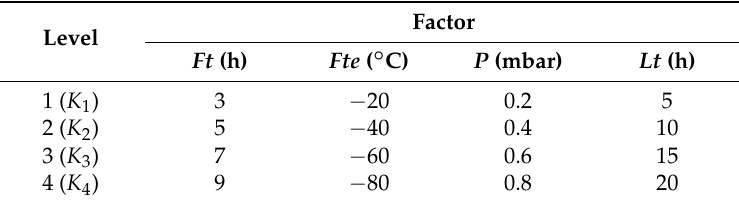
Table 1. Factors and levels used in the freeze-drying